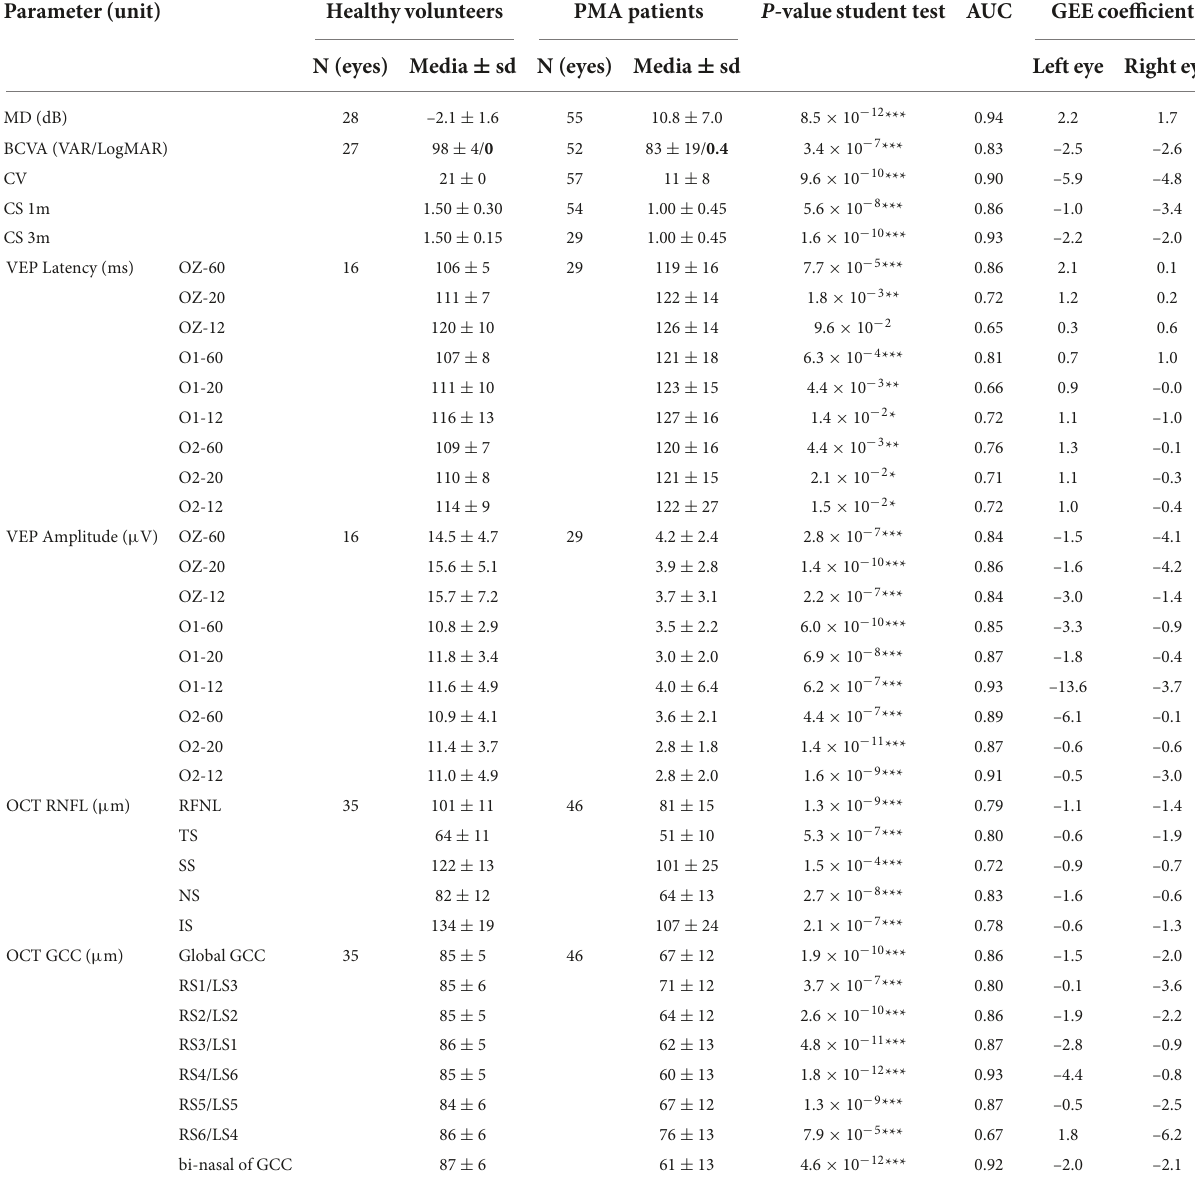
Values correspond to 57 eyes of 37 patients with pre-surgical pituitary macroadenoma and 35 eyes of 35 healthy volunteers selected by propensity score matching. VEP, visual evoked potential.OCT,opticalcoherencetomography.MD,mediandeviation.BCVA,best-correctedvisualacuity.CV,colorvision.CS1m,contrastsensitivityat1m.CS3m,contrastsensitivity at 3m. RNFL, retinal nerve fiber layer. Global GCC, global ganglion cell complex. Bi-nasal of GCC, bi-nasal sectors of GCC. O1. O2. Oz derivations. 60 (cid:48) -20 (cid:48) -12 (cid:48) frequencies of stimulus. ***: p < 0.001,**: p < 0.01,*: p < 0.05.